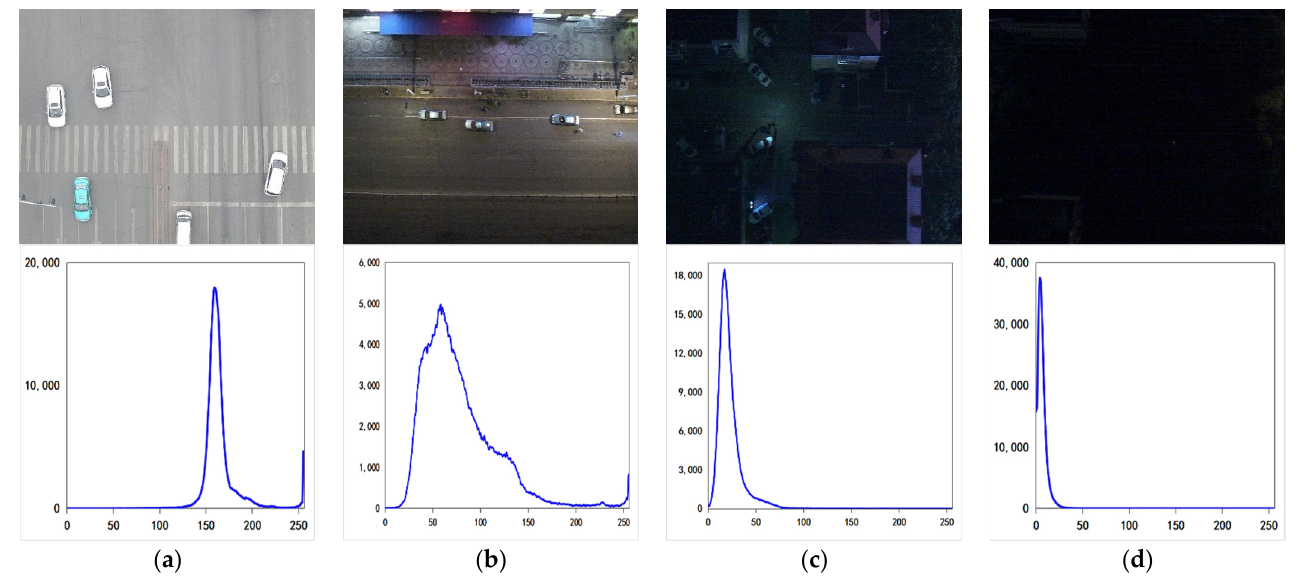
Figure 3. The first row is the RGB images of different lighting scenes, from ( a – d ) are daytime, weak light at night, strong light at night and dark night, and the second row is the corresponding histogram.